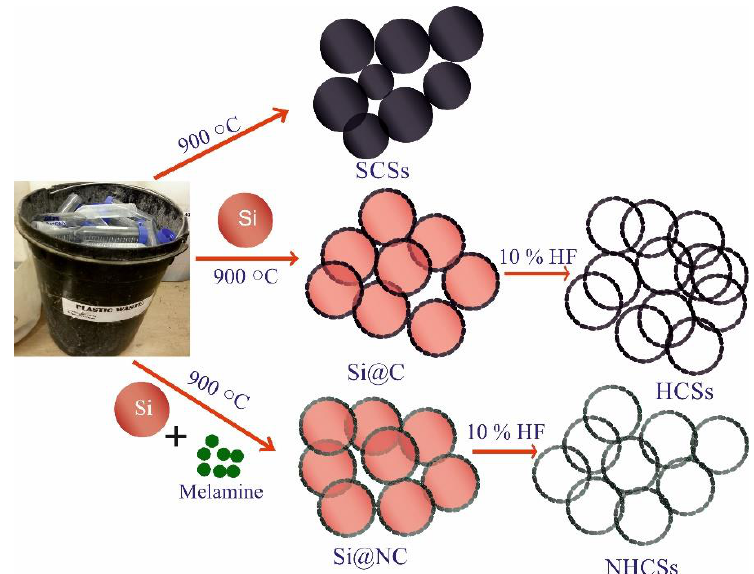
Figure 1. A graphical representation of solid carbon spheres (SCSs), hollow carbon spheres (HCSs), and nitrogen-doped hollow carbon spheres (NHCSs) synthesized from waste polypropylene (PP) material.